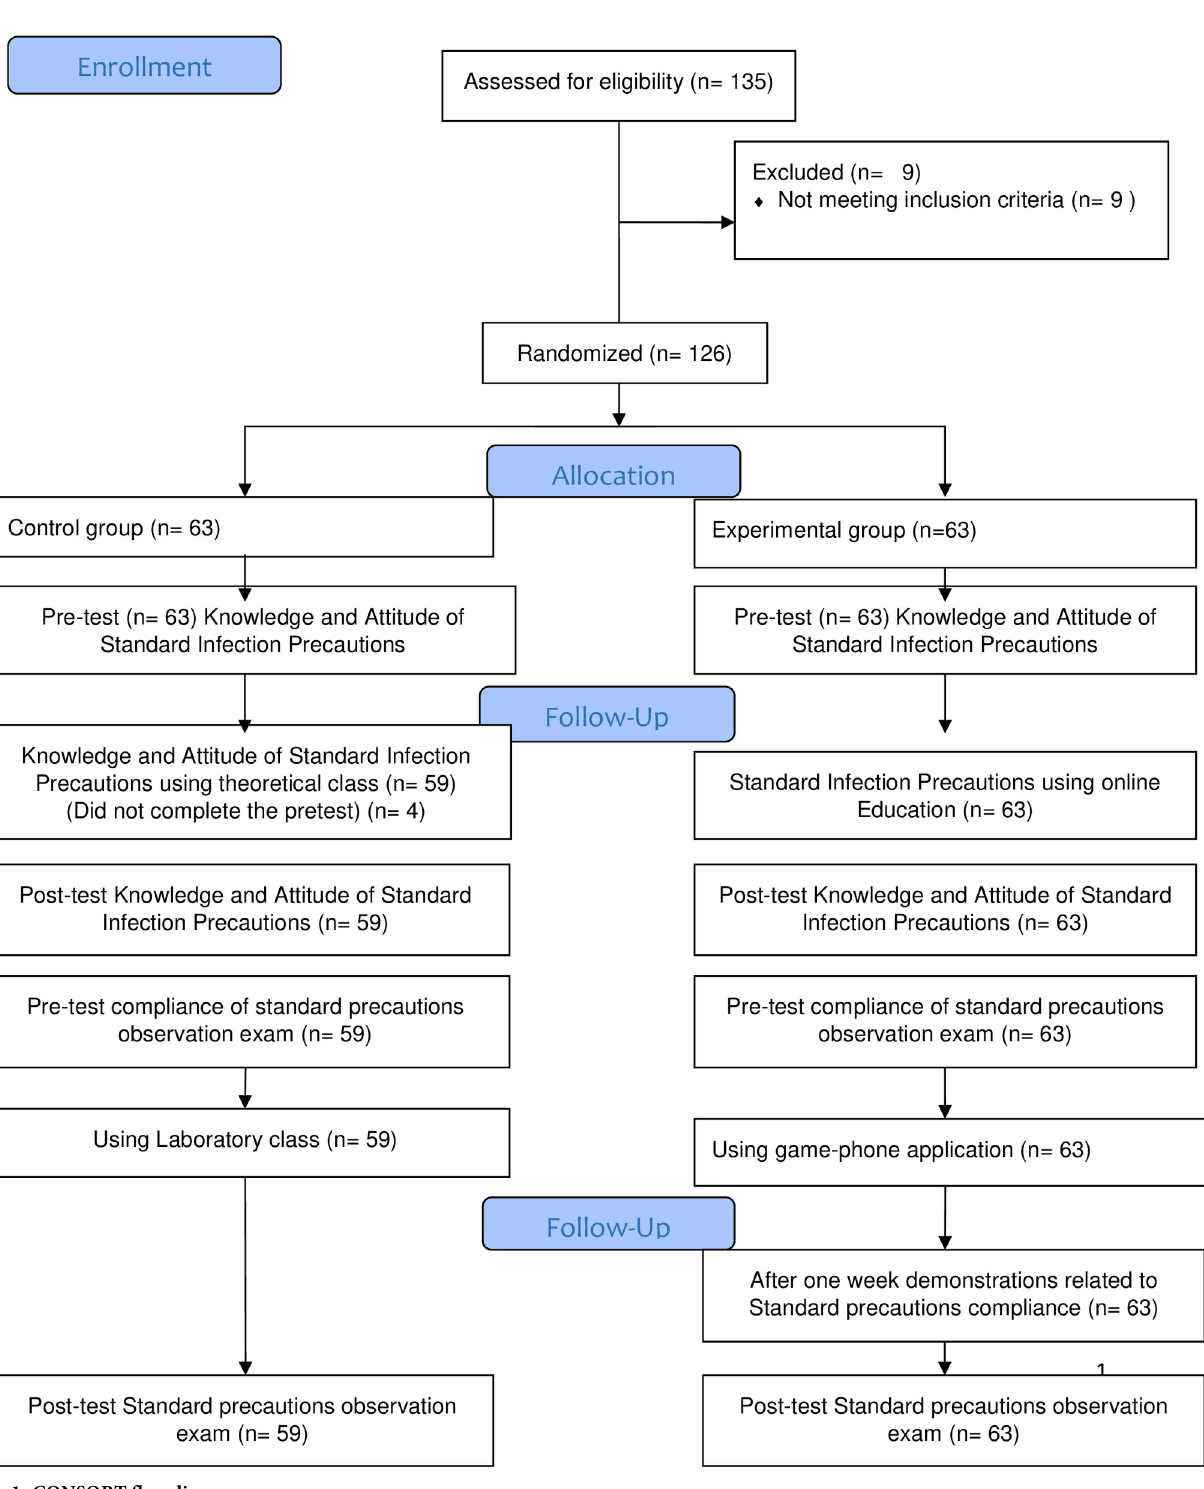
Fig 1. CONSORT flow diagram.